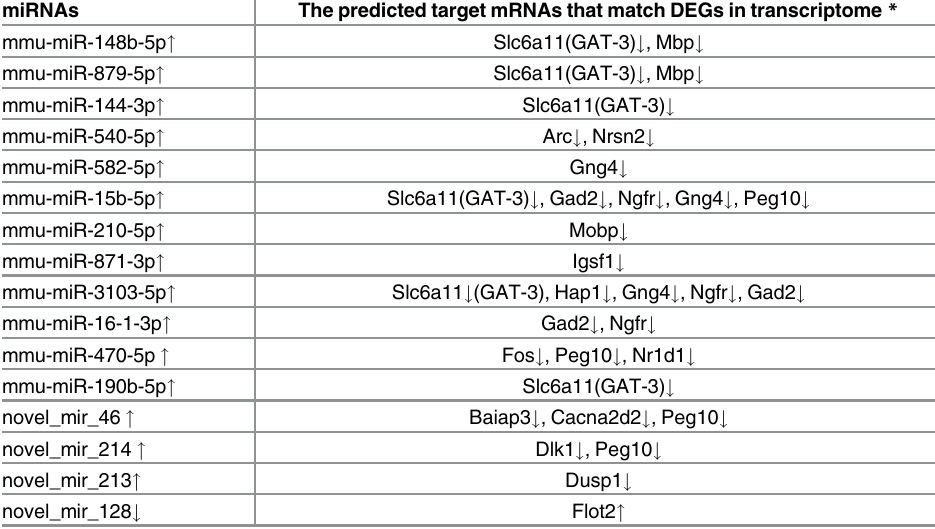
Table 4. The changed miRNAs predict target mRNAs. miRNAs The predicted target mRNAs that match DEGs in transcriptome * mmu-miR-148b-5p "